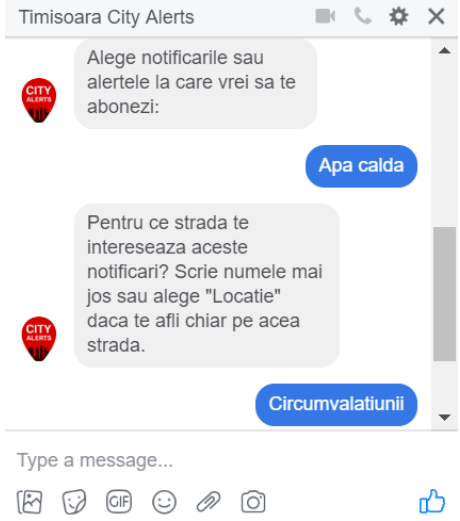
Figure 1 The City Alerts chatbot – Subscribing for a notification